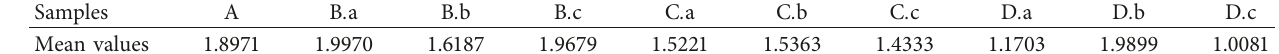
Table 1: Mean values of grouped samples (SKF6205-2RS).